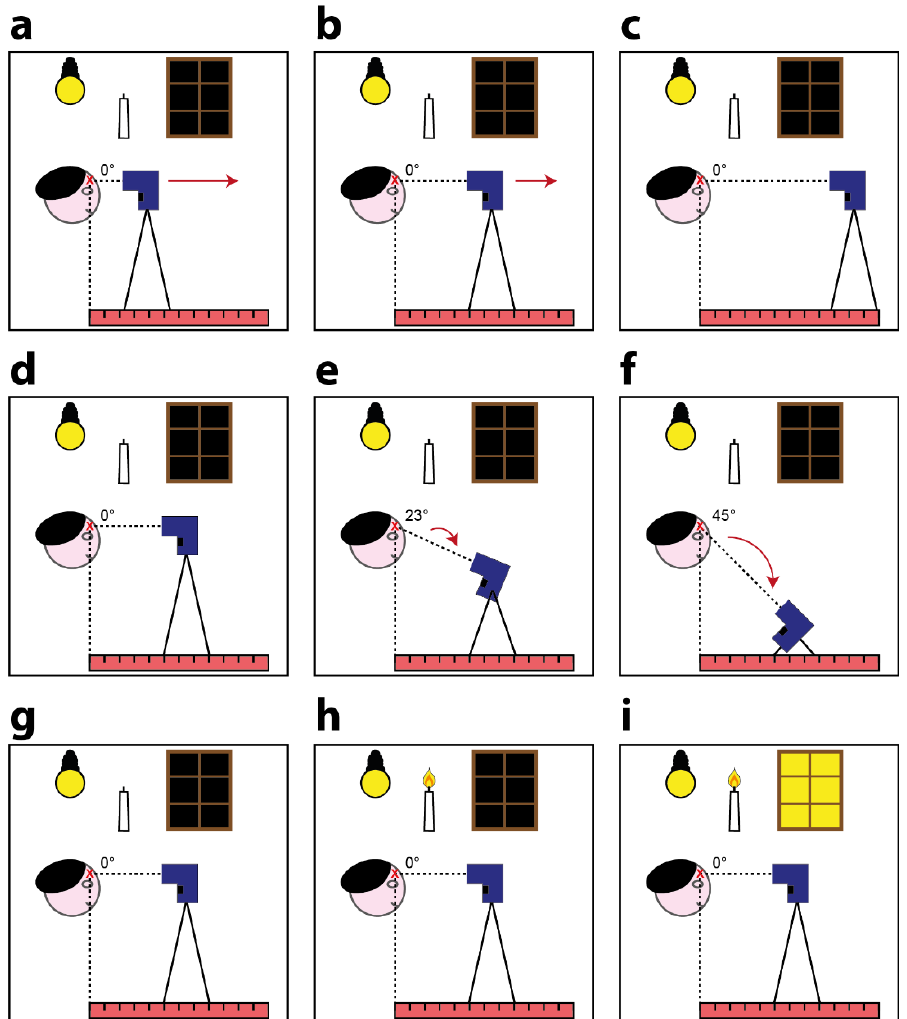
Figure 2. Schematic representation of the performed experiments: ( a – c ) body–device distance experiment: While keeping the light and the body–device angle conditions constant, we modified the distance of acquisition; ( d – f ) body–device angle experiment: while keeping the light and the body–device distance conditions constant, we modified the angle of acquisition; ( g – i ) light influence experiment: while keeping the body–device distance and the body–device angle conditions constant, we modified the illumination conditions during the acquisitions.